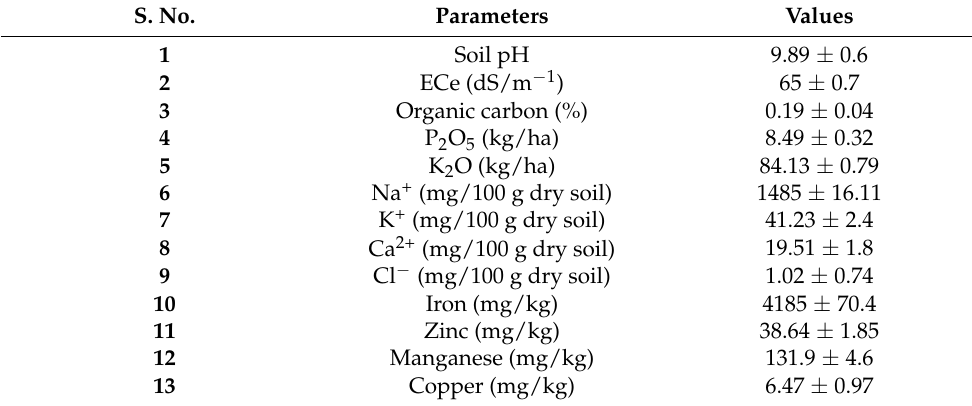
Table 1. Physiochemical properties of the soil at the collection sites (mean ± SD, n = 3). S. No.